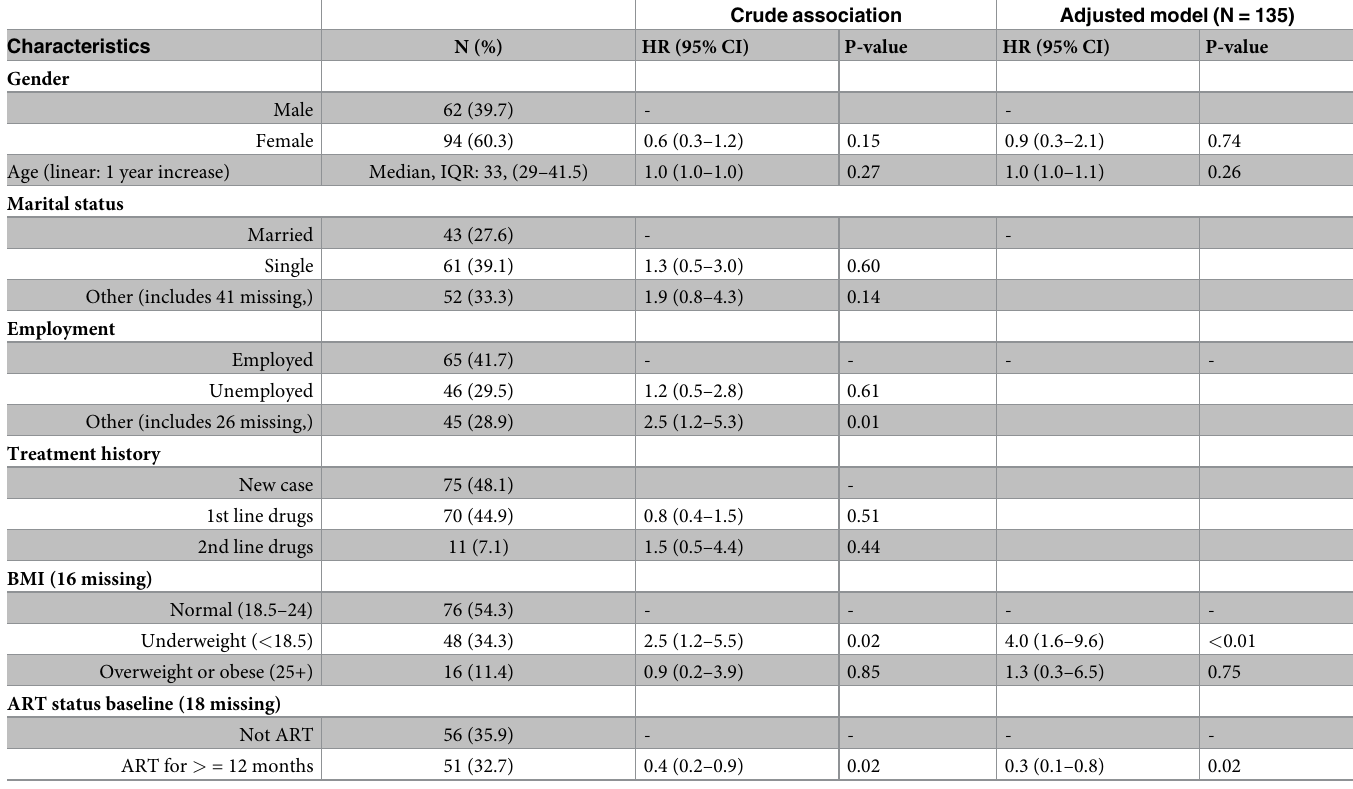
Table 4. Cox Hazard risk model to determine risk factors associated with unfavorable outcome (loss to follow up, treatment failure, death and not evaluated) among HIV positive patients. N =